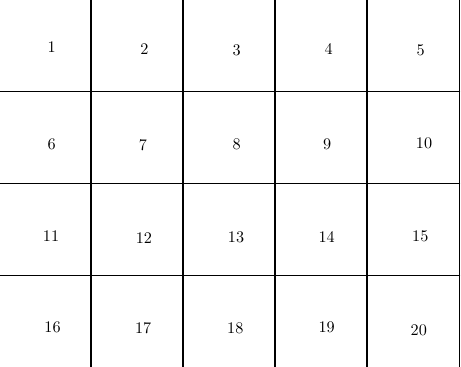
Figure 1. Example of a facility and its division in rectangular area